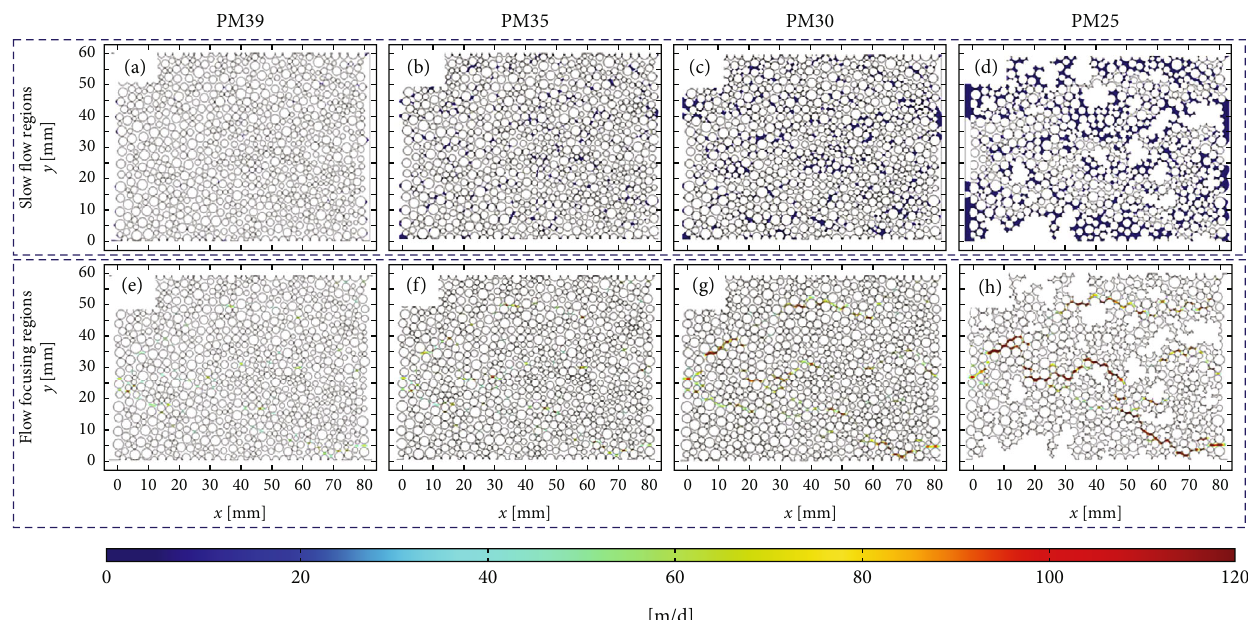
Figure 5: The slow fl ow regions (the blue areas in a, c, e, g) and fl ow focusing regions (the colored areas in b, d, f, h) in Group 1 porous media: PM39 (a, b); PM35 (c, d); PM30 (e, f); PM25 (g,